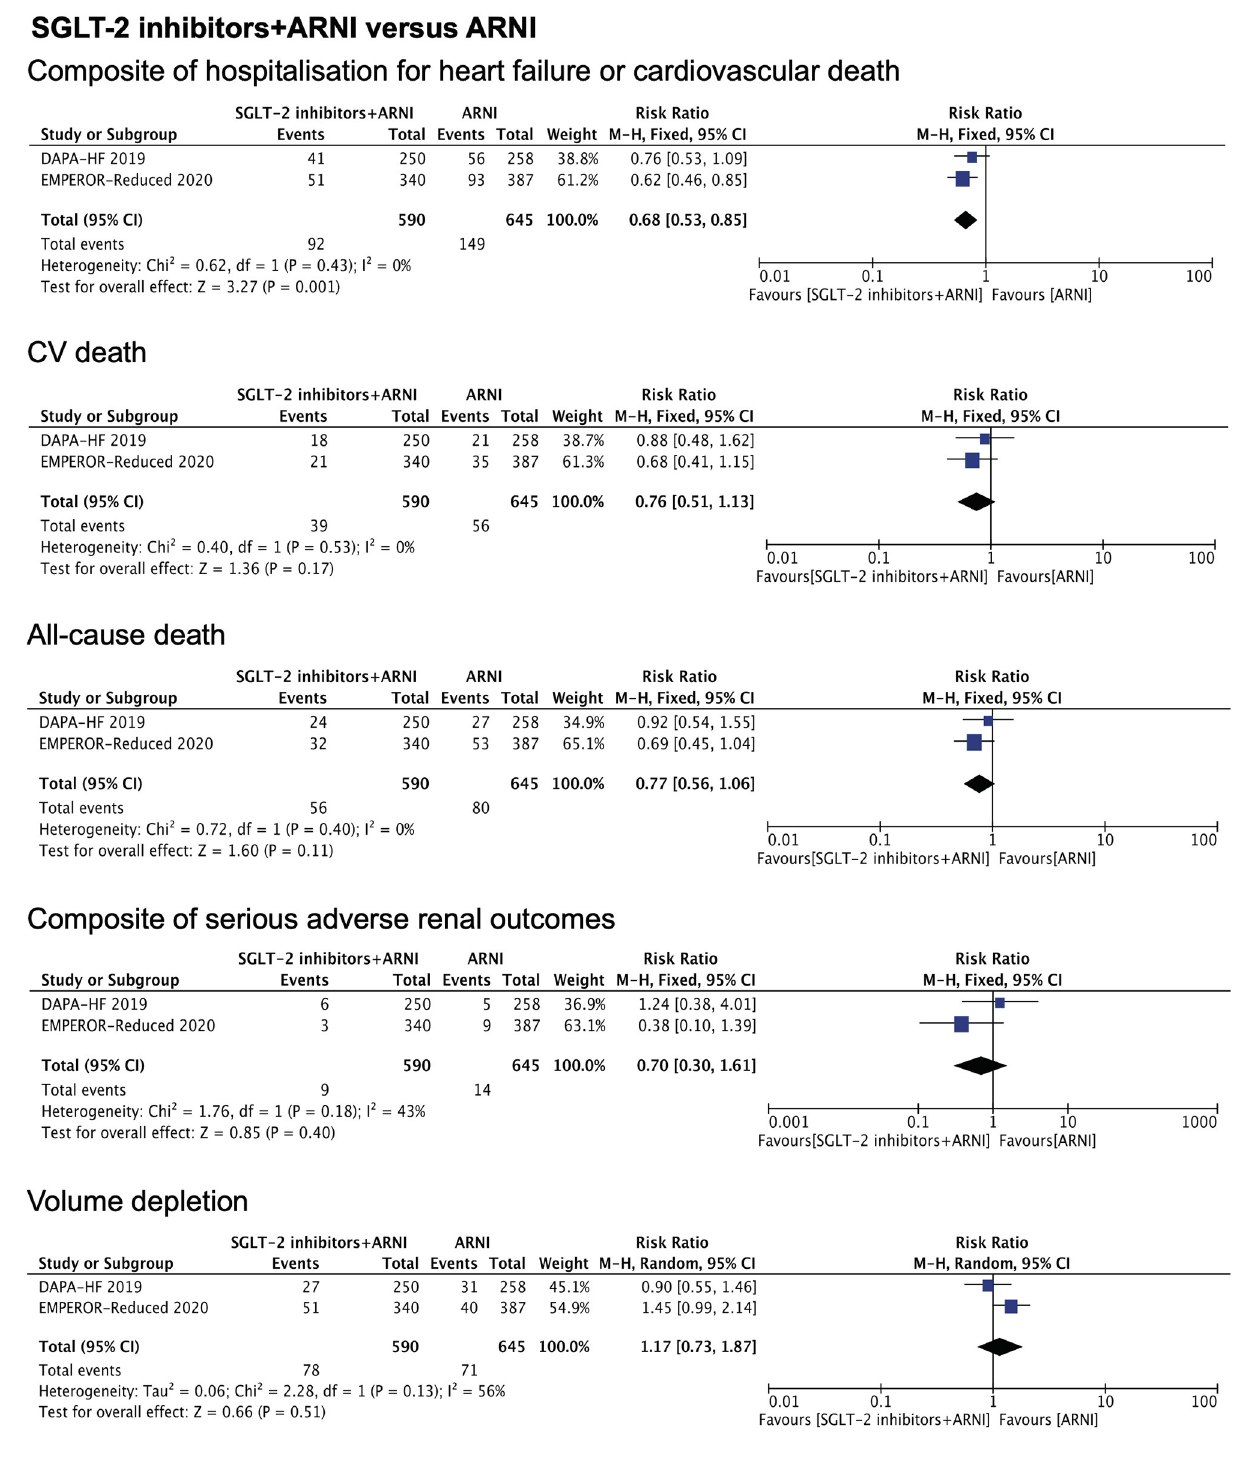
FIGURE 2 | Meta-analysis of DAPA-HF and EMPEROR-Reduced trials. Figure 2 shows the therapeutic effects of combination therapy compared with ARNI monotherapy on a composite of hospitalization for heart failure or cardiovascular death, CV death, all-cause death, composite of serious adverse renal outcomes, and volume depletion. The composite of serious adverse renal outcome was defined as chronic dialysis or renal transplantation or a sustained reduction ( ≥ 40%) in the eGFR or a sustained eGFR of < 15 ml/min/1.73 m 2 in patients with a baseline eGFR of ≥ 30 ml/min/1.73 m 2 or a sustained eGFR of < 10 ml/min/1.73 m 2 in those with a baseline eGFR of < 30 ml/min/1.73 m 2 in EMPEROR-Reduced trial. For the DAPA-HF trail, it was defined as a continuing decline of the eGFR ( ≥ 50%) for at least 28 days, end stage renal disease (ESRD), or death from renal causes. ESRD was defined as an eGFR of < 15ml/min/1.73 m 2 that was sustained for at least 28 days, sustained ( ≥ 28 days) dialysis treatment, or renal transplantation. eGFR, estimated glomerular filtration rate; RR, rate ratio.